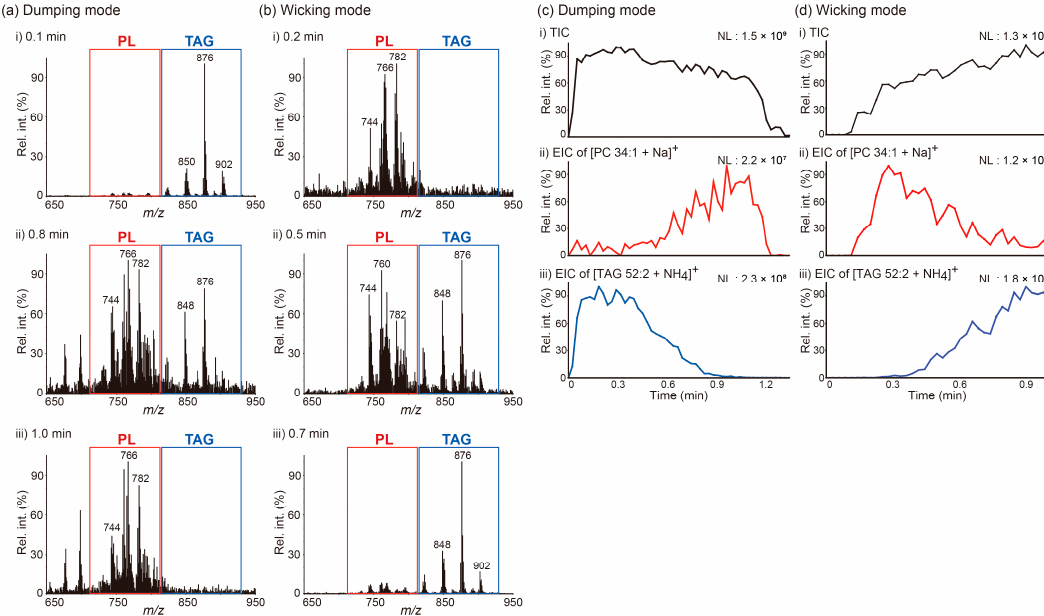
Figure 2. ( a and b ) Averaged paper spray ionization (PSI) mass spectra of a beef lipid extract recorded at the indicated acquisition times. ( c and d ) i) Total ion chronograms (TICs) of PSI mass spectrometry analysis of a beef lipid extract and extracted ion chronograms (EICs) for ii) the [PC 34:1 + Na] + ion at m/z 782 and iii) the [TAG 52:2 + NH 4 ] + ion at m/z 876. A PSI solvent (5 mM NH 4 Ac in MeOH) was applied either ( a and c ) via the dumping or (b and d) wicking modes. NL denotes the normalized level. MeOH: methanol; NH 4 Ac: ammonium acetate; PC 34:1: phosphatidylcholine 34:1; TAG 52:2: 1,3-dioleyl-2-palmitoyl-glycerol.